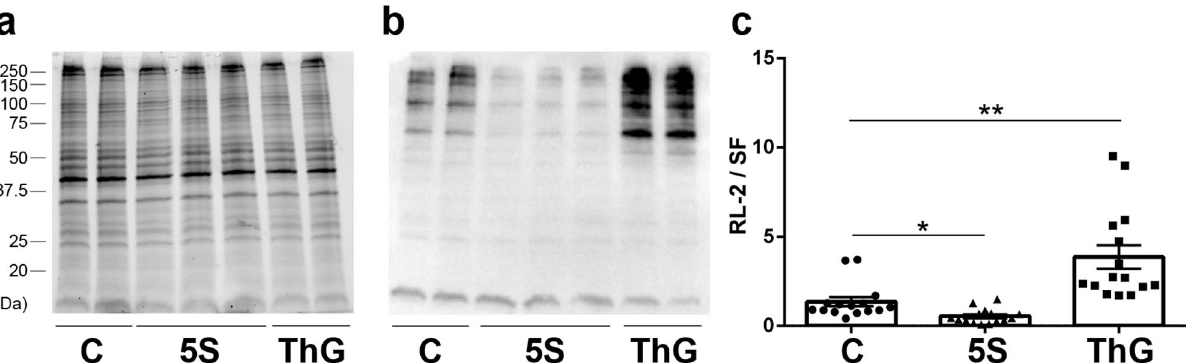
Figure 2. Quantification of global O-GlcNAcylation level in C2C12 myotubes following Ac 4 -5S-GlcNAc (5S, ▲ ) or Thiamet G (ThG, ■ ) treatment. Twenty µg of proteins sample extracted with RIPA buffer were resolved on 7.5% acrylamide Stain-free gels and analysed by western blot. ( a ) Whole protein profiles detected using Stain-Free technology. ( b ) O-GlcNAcylation pattern revealed with RL-2 antibody. ( c ) Quantification of western blot signals, normalized to Stain-Free profile. Data were expressed as mean ± SEM and compared with the control condition. *p < 0.05, **p < 0.01 significantly different from control (n = 15, N = 3 independent cultures). Uncropped images of gel and blot are presented in Supplemental